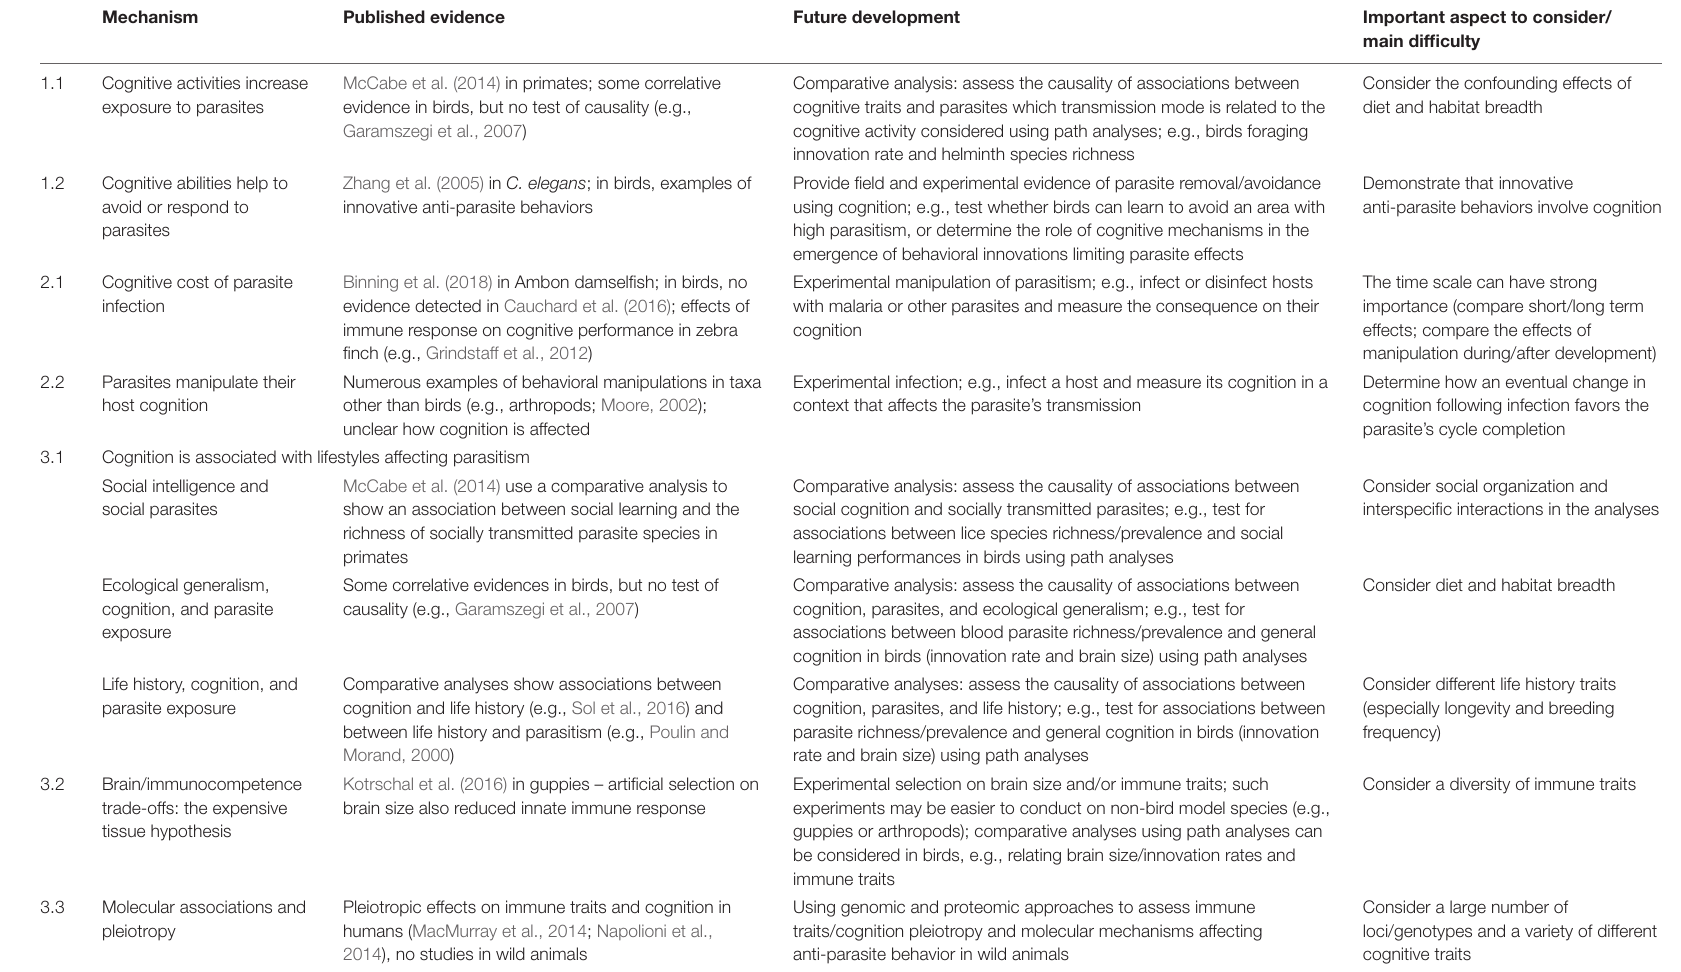
TABLE 2 | Main mechanisms predicting associations between parasitism and cognition, with examples from the literature and analyses/experiments required to provide more evidence for the different